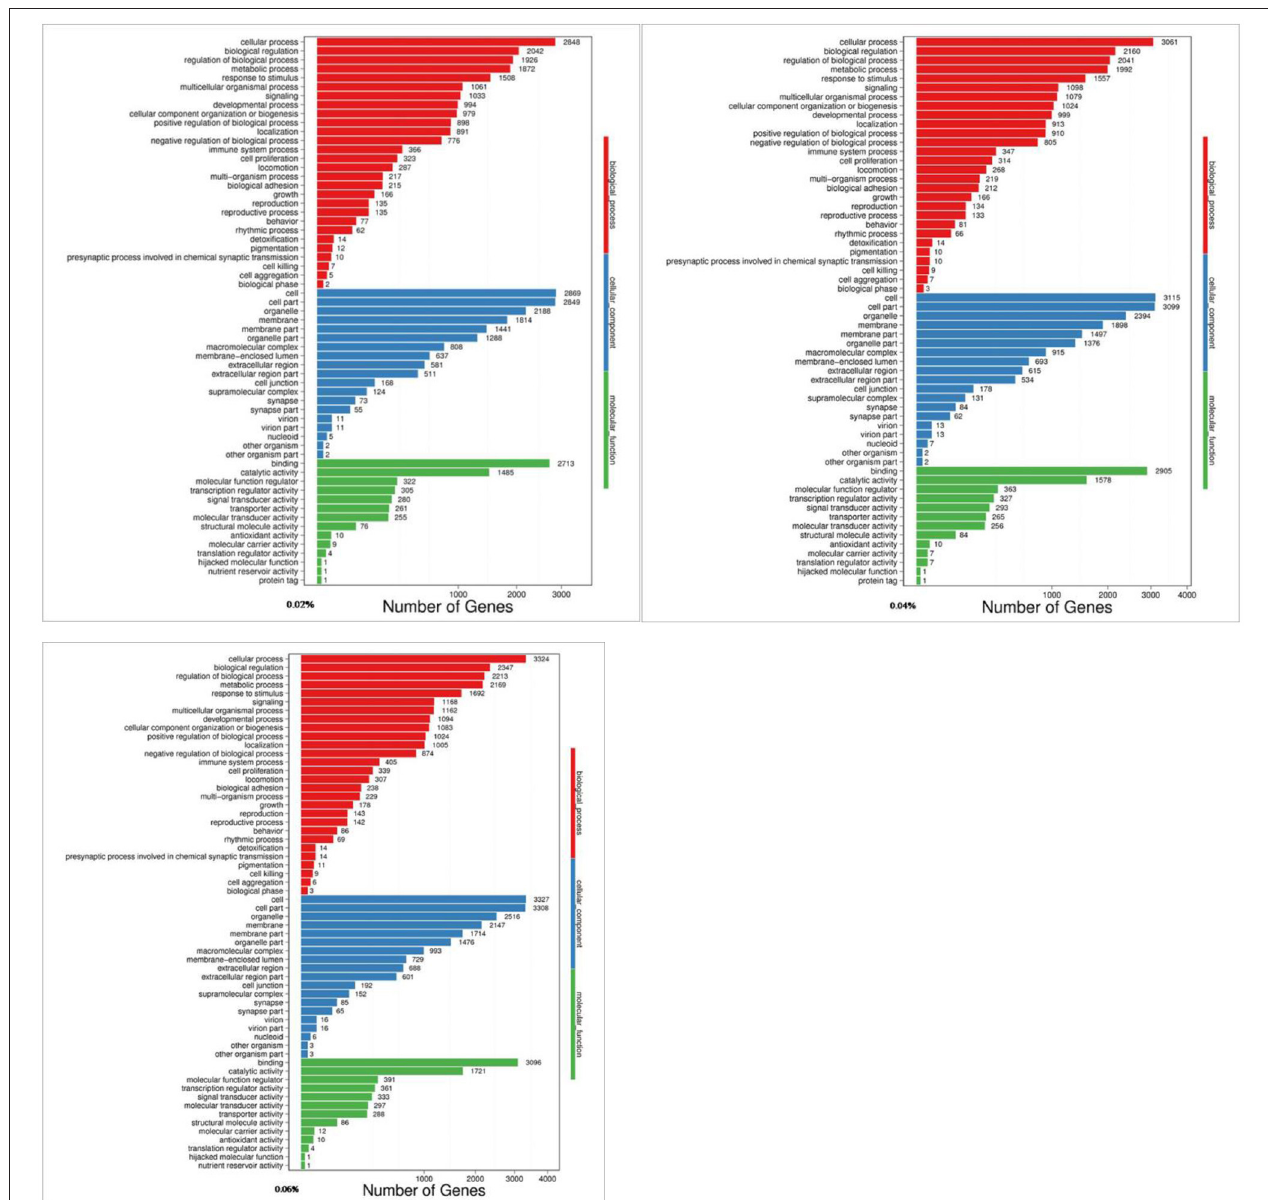
FIGURE 2 | GO analyses of quercetin affecting differentially expressed genes in the duodenal mucosa of broilers (0.02, 0.04, and 0.06%).